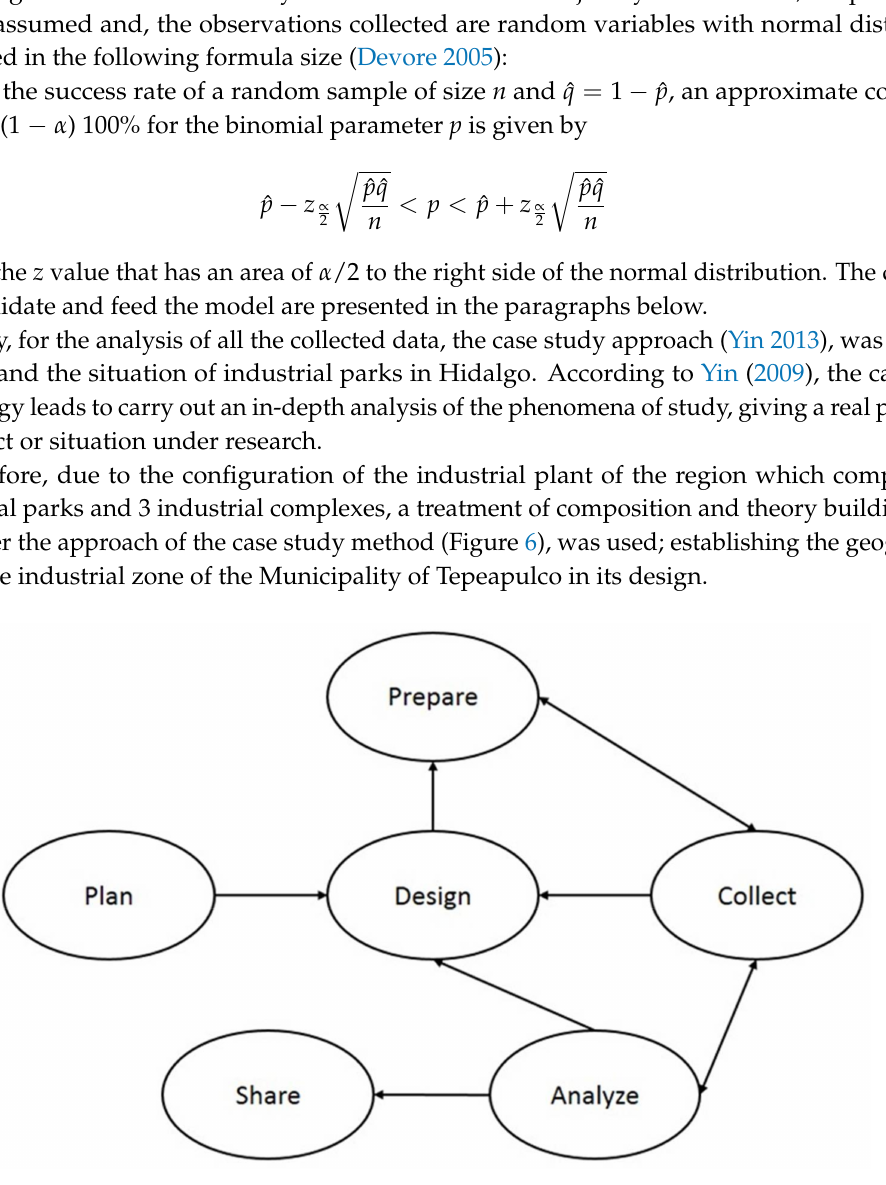
Figure 6. Case study methodology. Yin